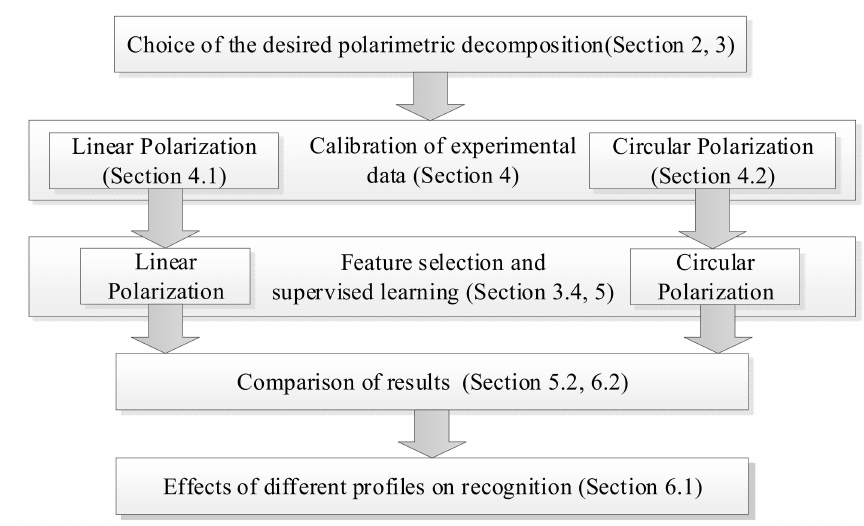
Figure 2. Structure of the